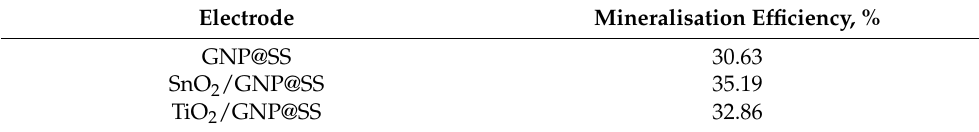
Table 4. Degree of mineralisation (%) obtained by TOC analysis at the investigated electrodes.